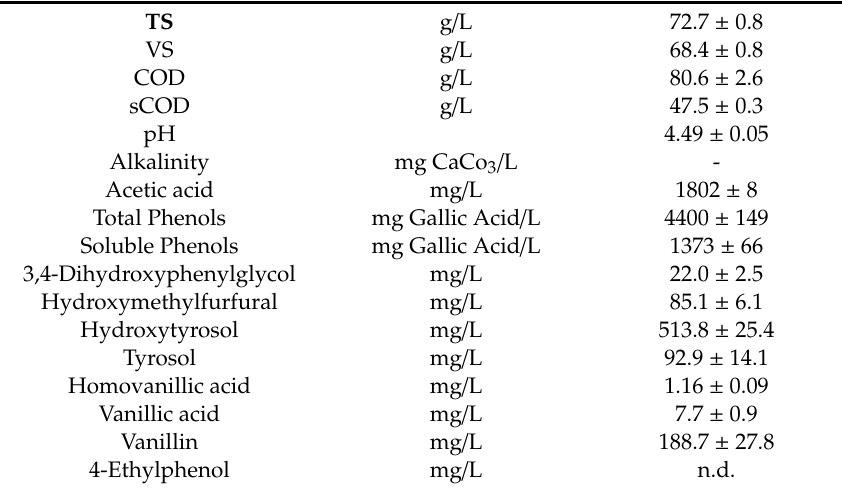
Table 1. Characterization of the Olive Mill Solid Waste